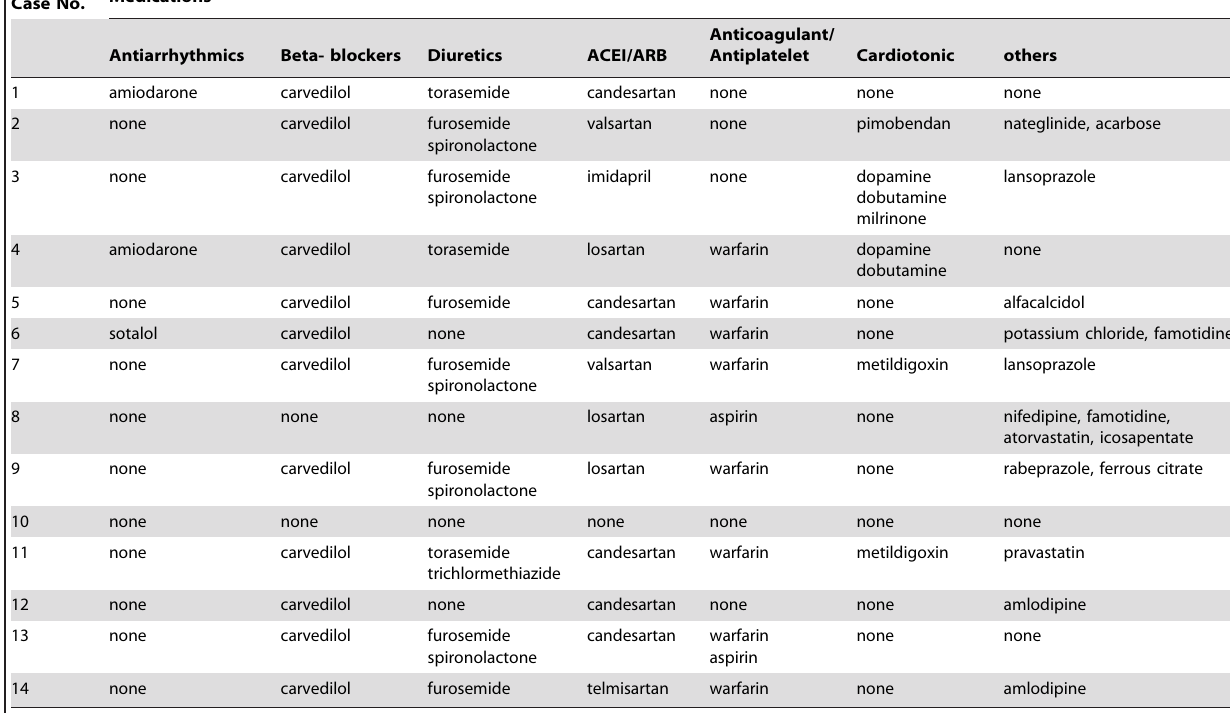
Table 2. Patient’s